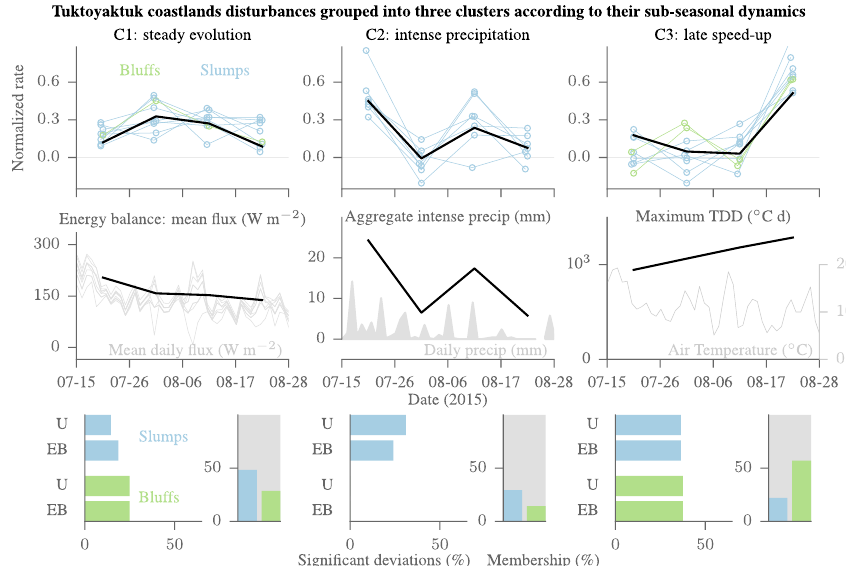
Figure 5. Slumps and bluffs in the Tuktoyaktuk coastlands were grouped into three clusters (C1–C3) according to their sub-seasonal elevation loss dynamics after mid-July. The first row contains the normalized rates of the three clusters (aggregated over the headwall; absolute elevation changes sum to one), with the time series of selected slumps and bluffs shown in blue and green respectively, and the representative cluster dynamics in black. The second row contains the available energy (grey: daily values for different headwall orientation; black: aggregate values for horizontal orientation), the precipitation (daily values measured in Inuvik in grey; aggregate values for days with intense precipitation > 5mm in black) and the air temperature measured in Inuvik (daily values in grey; maximum thawing degree days, TDD, between successive acquisitions in black). The third row contains the percentage of landforms for which the null hypothesis of uniform (U) or energy balance- limited (EB) elevation losses was rejected (horizontal bars) and the percentage of landforms that were classified in the respective cluster (vertical bars). Please note that dates are shown in month/day